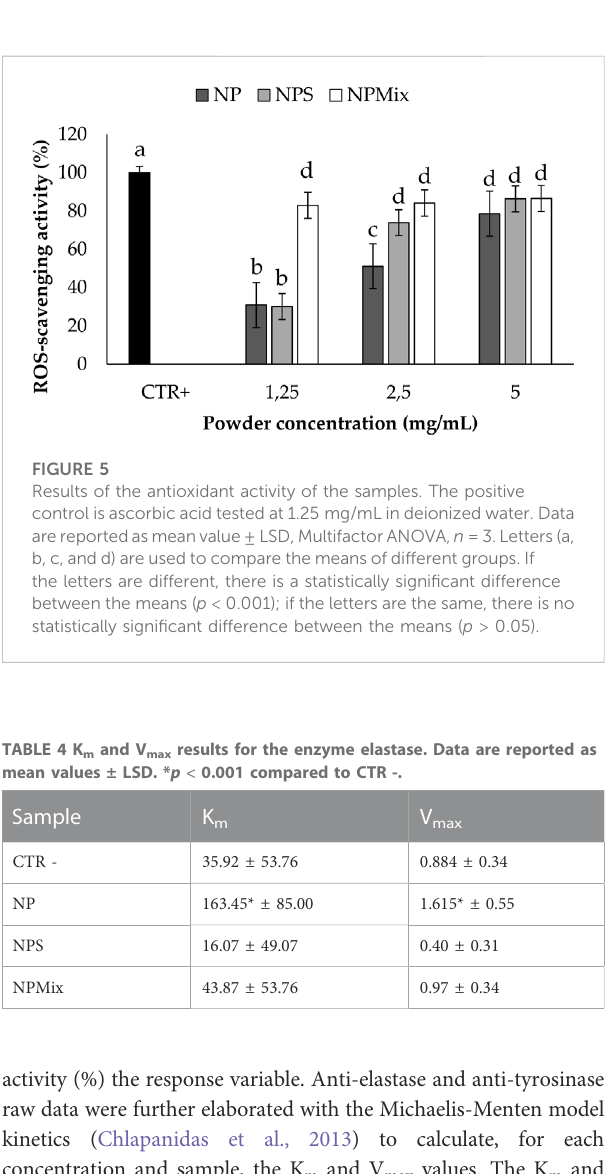
and the cell metabolic activity (%) as the response variable. Finally,